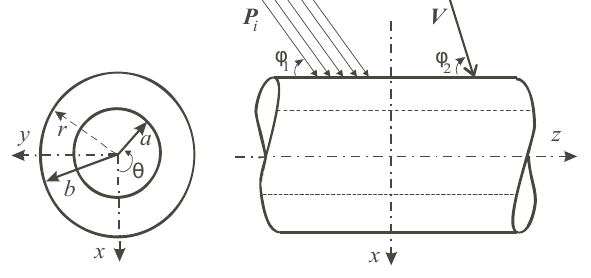
Fig. 1. Infinite cylinder exposed to the incident wave and external medium